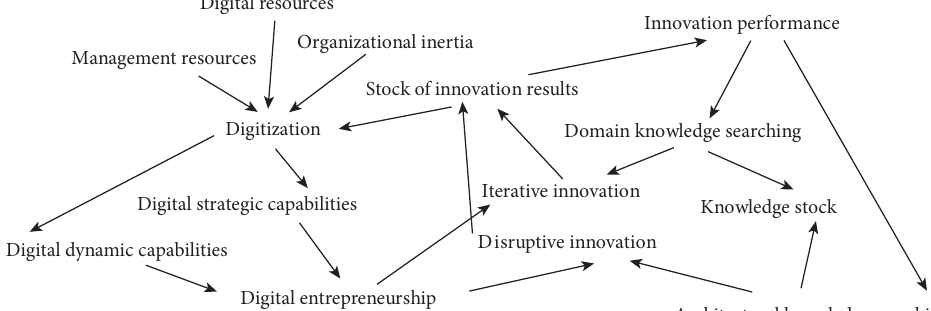
Figure 2: The causal loops